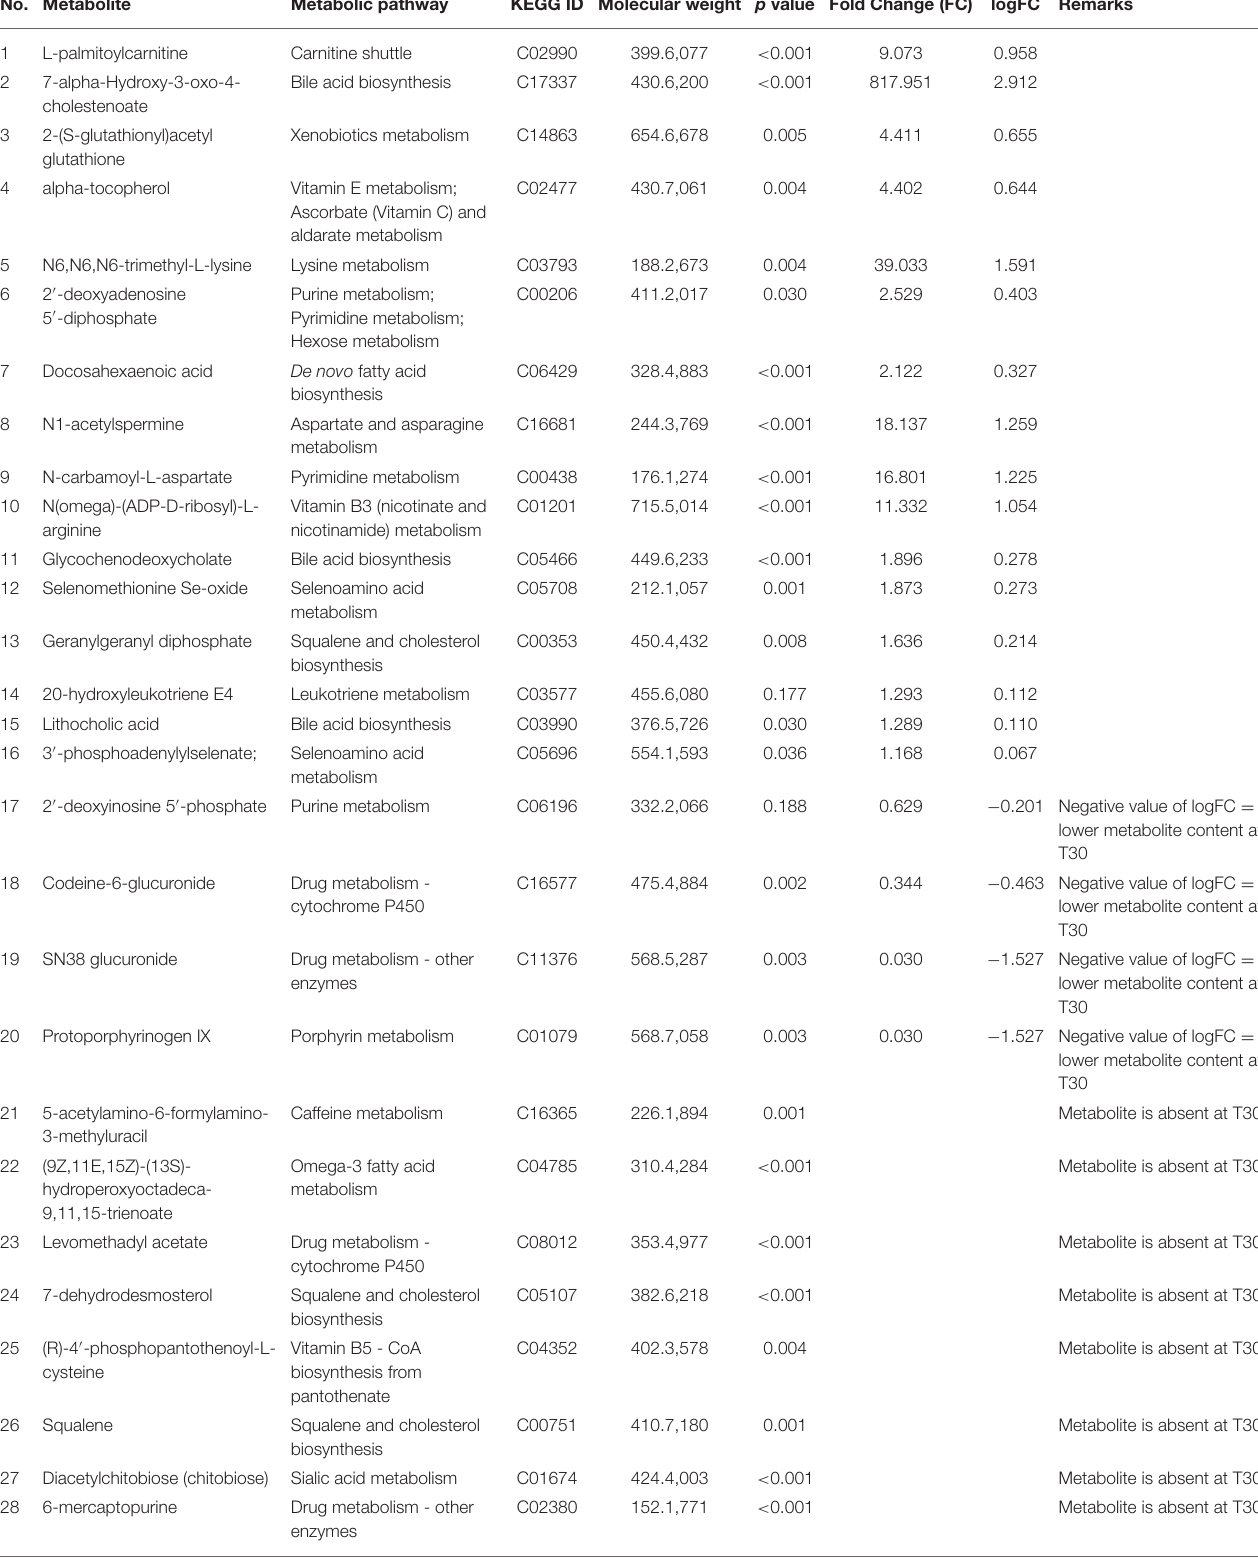
TABLE 4 | List of significantly ( p < 0.05) regulated metabolites in dog saliva after 30 days of Ascophyllum nodosum administration. No.